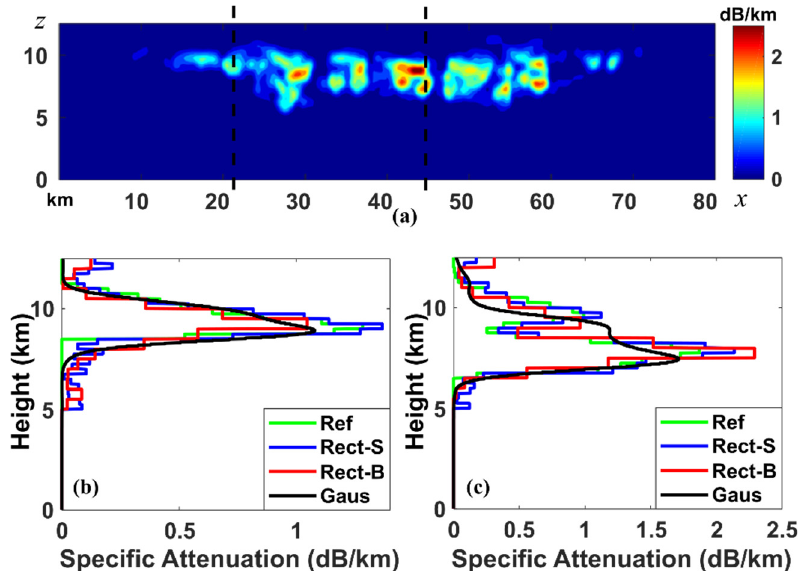
Figure 5. Panel ( a ): The final retrieved attenuation field using Gaussian basis functions. Panel ( b ): Specific attenuation versus height along a vertical line located at x = 21 km, where the green line is for the reference field, the blue line is for the retrieved field using small rectangular basis functions ( u = 250 m ) , the red line is for the retrieved field using large rectangular basis functions ( u = 500 m ) and the black line is for the retrieved field using Gaussian basis functions. Panel ( c ): Plots for a vertical line located at x = 45 km.